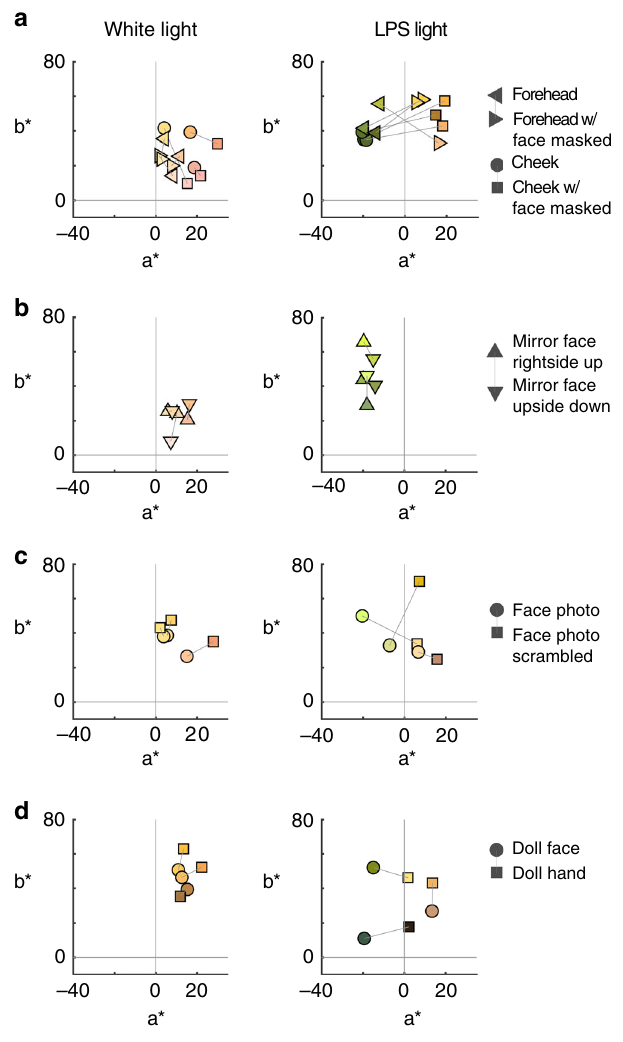
Fig. 6 Paradoxical color matches for faces are evident in mirror inverted faces, photos, and a doll face. Color matches under white light and low-pressure sodium light; corresponding stimuli are connected by a line (see key). Data were collected in three participants (#5, 7, 19, in Fig. 1). a Forehead and masked-forehead, and cheek and masked cheek. Matches to the masked condition are to the right of the matches to the unmasked condition. b Faces seen upright and upside-down in a mirror. For the upside-down condition, matches were made by looking down at a mirror view of the face. c Photograph of a Caucasian female face and scrambled photograph of the face. d Doll face and doll hand; the doll hand did not show a paradoxical color match for any participant. Symbol color corresponds to the color of the match. Source data are provided as a Source Data fi signal is still reddish. The green appearance of faces under LPS